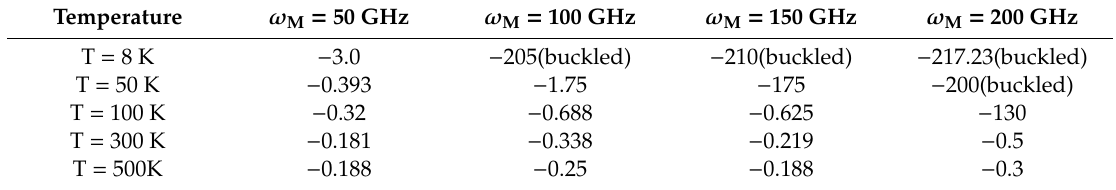
Table 2. Critical values of the resistant moment, i.e., M rcr , on the rotor in the zigzag model. Unit of the moment: eV. Sign convention: Minus sign means the direction of M r is opposite to that of ω M .